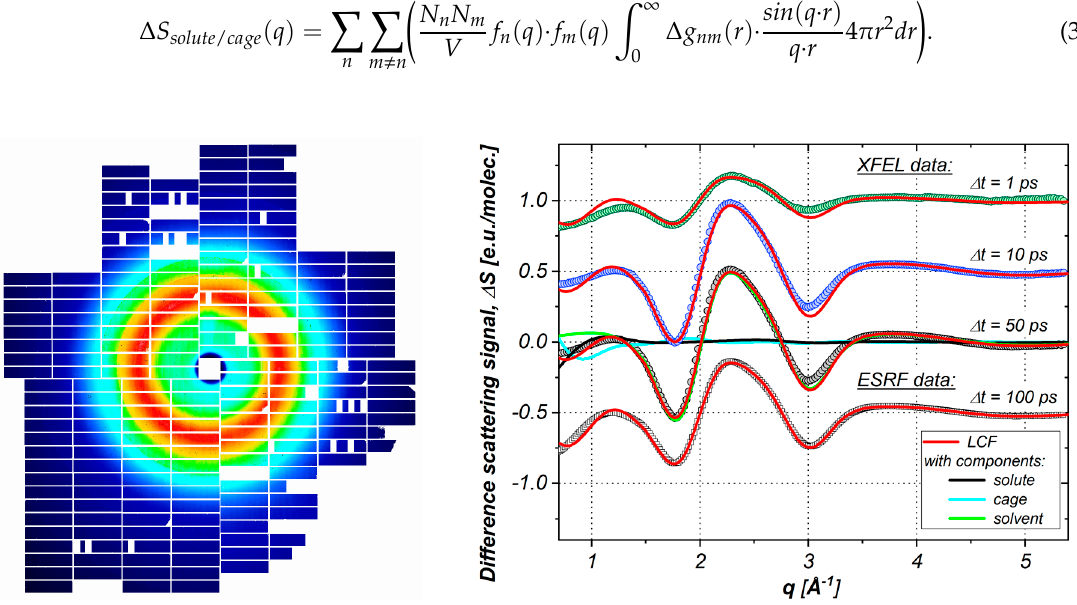
Figure 5. Left : average LPD image (200 shots) of WAXS from an aqueous solution of [Fe(bpy) 3 ] 2+ collected with 12 keV X-ray photons. Right : difference scattering curves measured in a pump-probe experiment at FXE (top 3 traces) and ESRF (the bottom trace, scaled by factor of 3) shifted vertically for clarity and the respective linear combination fits of the scattering data (red curves).